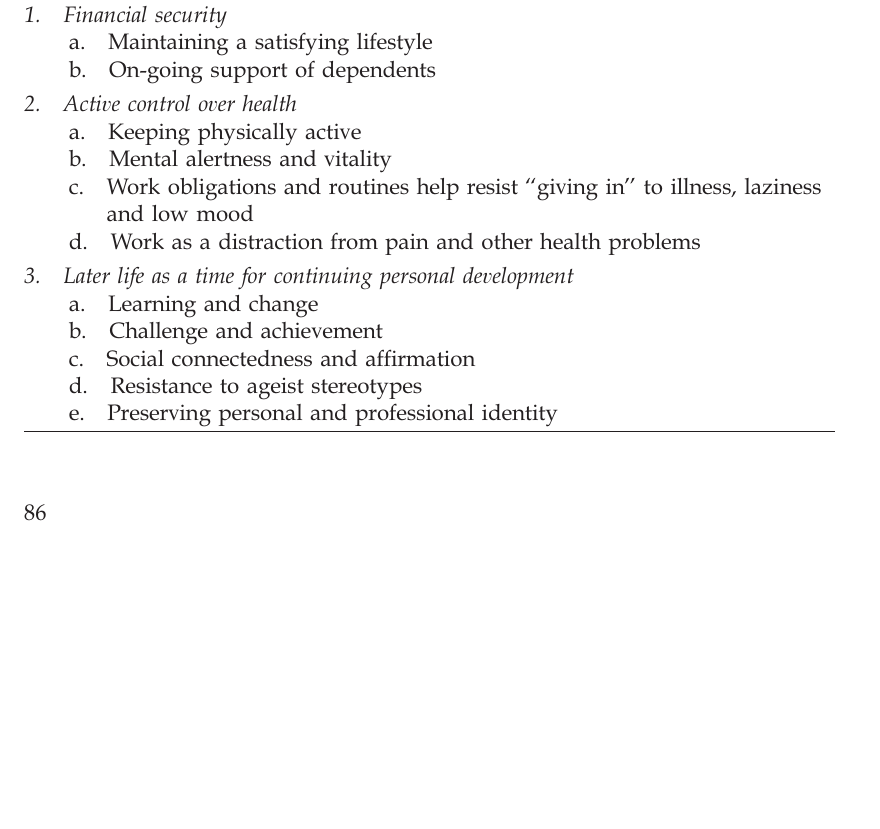
Table 1. Inter v iew themes: subjecti v e benefits of working beyond 65 1. Financial